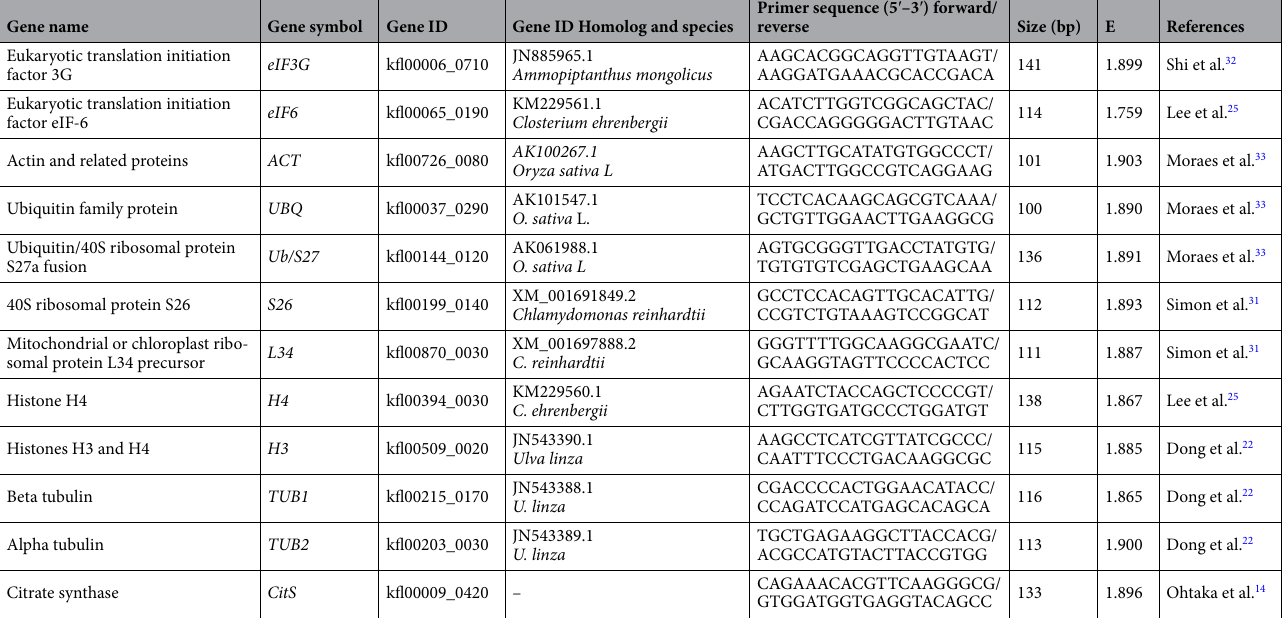
Table 1. Candidate reference genes and associated primers set used in RT-qPCR. K. nitens genes ID, the homologous genes and the related publications are referenced. Amplicon size and RT-qPCR efficiency (E) are